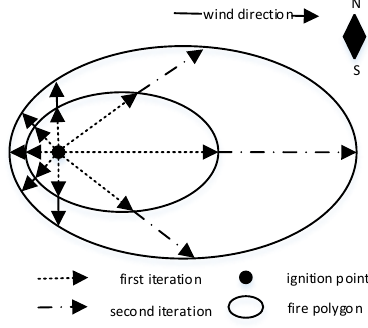
Figure 1. The dynamic process of fire spread